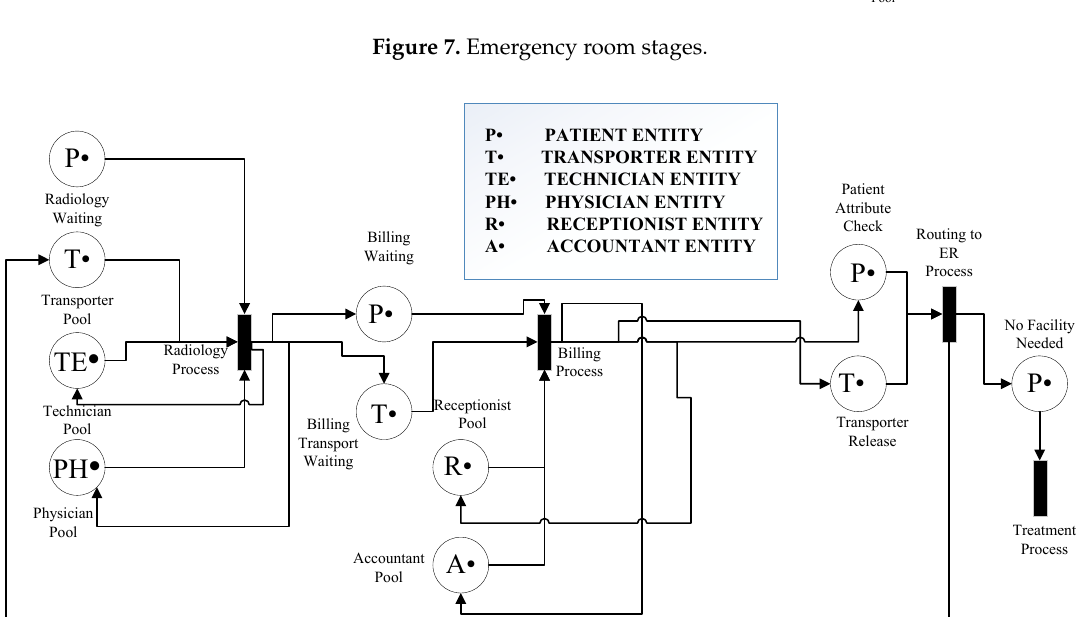
Figure 7. Emergency room stages.